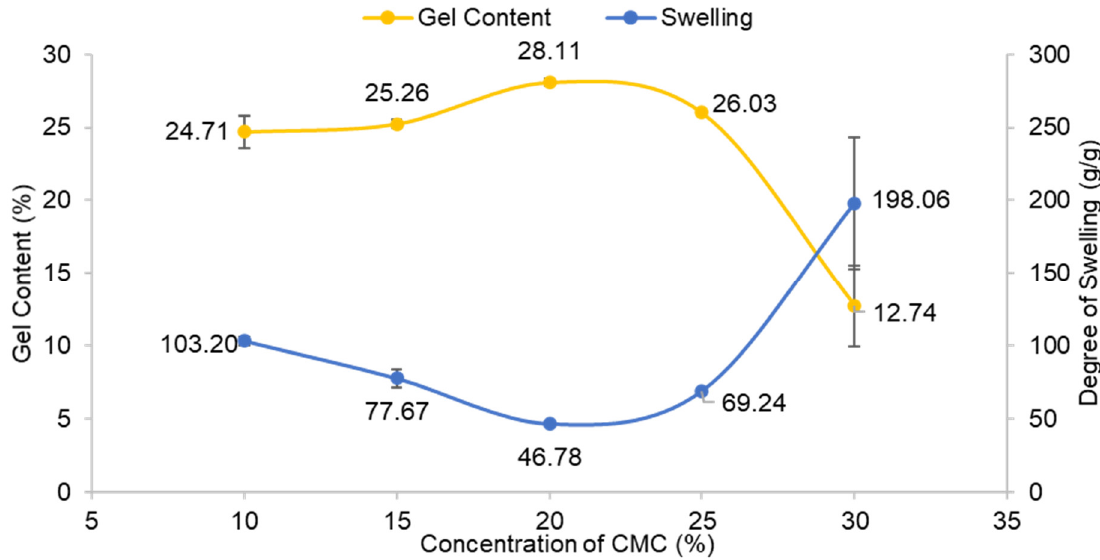
Figure 2. Effect of concentration of CMC on gel content and degree of swelling of CMC hydrogel. Error bar indicates the standard deviation of uncertainty.